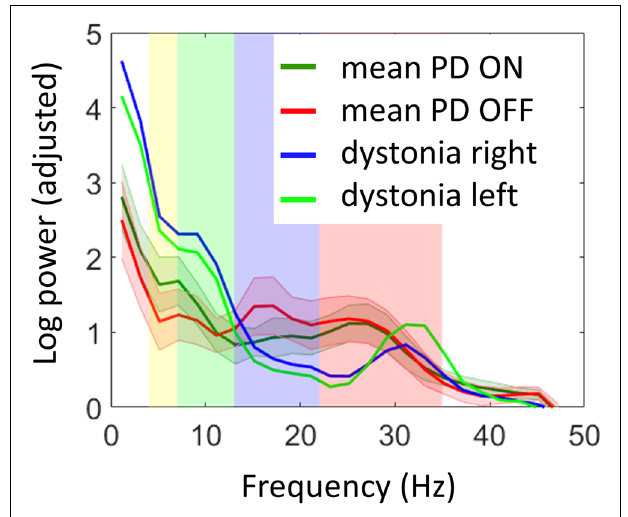
FIGURE 3 | Comparison of STN power spectra of the dystonia patient with the previously reported Parkinson’s disease (PD) cohort (Litvak et al., 2011a). Log power was normalized by subtracting a linear fit to the spectrum in the 55–95 Hz range. The shaded error bars denote 95% confidence intervals for the mean of PD spectra. The background color shows the standard electrophysiological frequency bands: theta (yellow, 4–7 Hz), alpha (green, 7–13 Hz), low beta (purple, 13–22 Hz) and high beta (pink, 22–35 Hz). The dystonia patient showed increased power in theta and alpha bands and reduced power in low beta (see “Results” section for